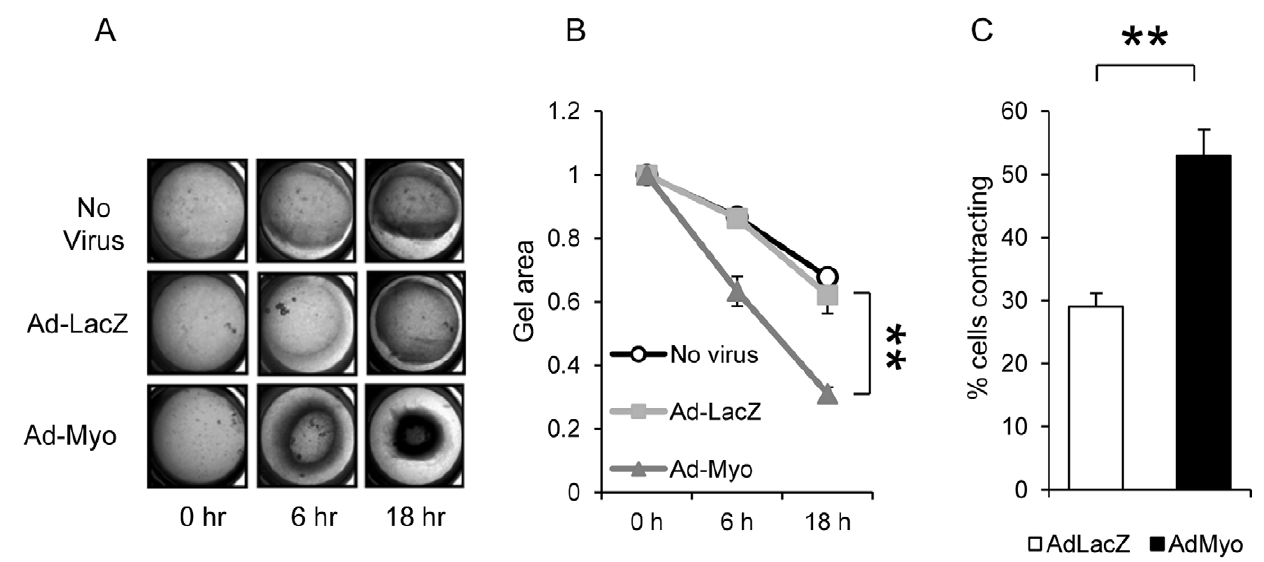
Figure 6. Contractile phenotype is promoted by myocardin overexpression. Embryoid bodies were treated with Ad-LacZ or Ad-Myo from day 10 to day 28, dispersed into a single cell suspension and seeded into collagen gels in 24 well plates (A). Gel contraction in response to carbachol was significantly increased in the Ad-myo group (B). Data points represent the means ( 6 s.e.m.) of three experiments. SMCs derived from human ESCs using a 2-dimensional culture protocol were individually examined for contraction following transduction with Ad-LacZ or Ad-Myo using time lapse microscopy. Percentage of contractile cells increased from 29% with Ad-LacZ to 53% with Ad-Myo (C). Results represent the mean values ( 6 s.e.m.) from 10 randomly chosen optical fields. **p , 0.01.